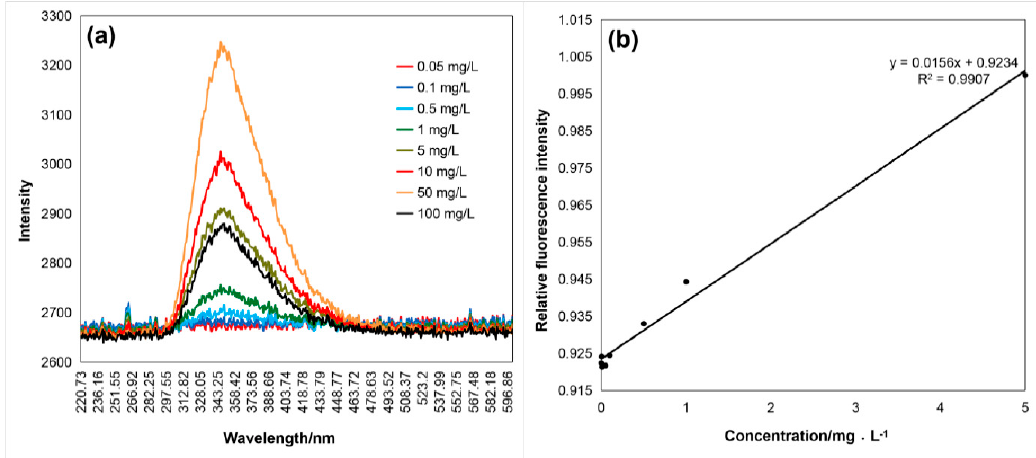
Figure 5. ( a ) Fluorescence spectrum ( λ max1 = 350 nm) of tryptophan excited by the 266 nm laser, ( b ) relation curve between the normalized fluorescence peak intensity, I F 1 , and the tryptophan concentration, C 1 , of 0.05–100 mg/L with a coefficient of determination of 0.9907.